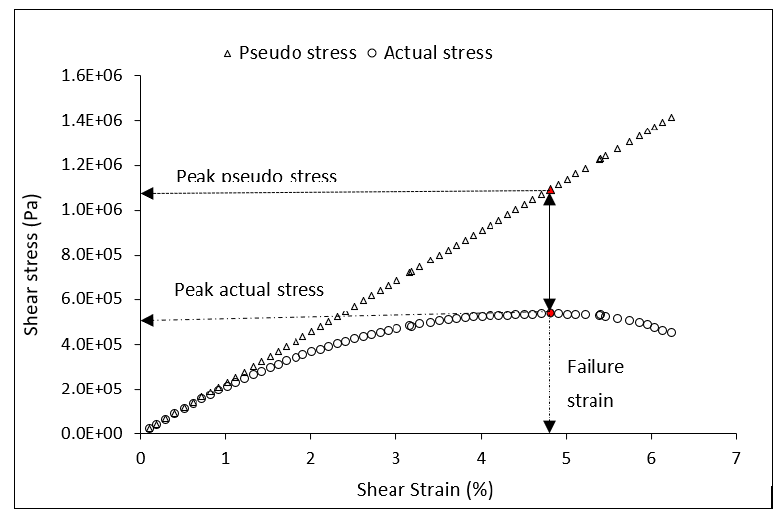
Figure 4. Variation of actual stress and pseudo stress as a function of shear strain.